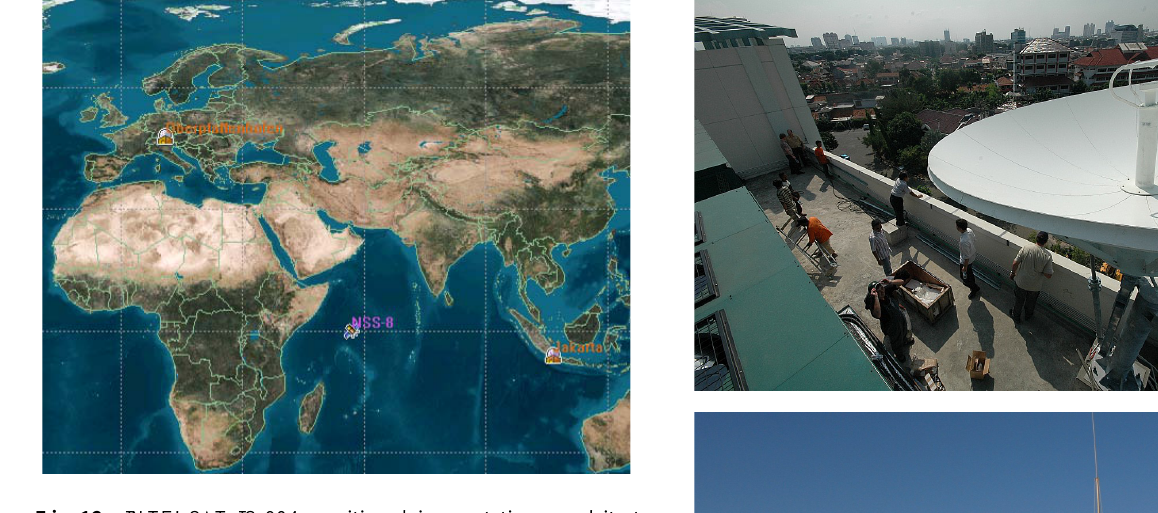
Fig. 12. INTELSAT IS-904, positioned in geostationary orbit at 60 ◦ East, well between Oberpfaffenhofen (48 ◦ 4 0 N, 11 ◦ 16 0 O) and Jakarta (6 ◦ 11 0 S, 106 ◦ 50 0 O).